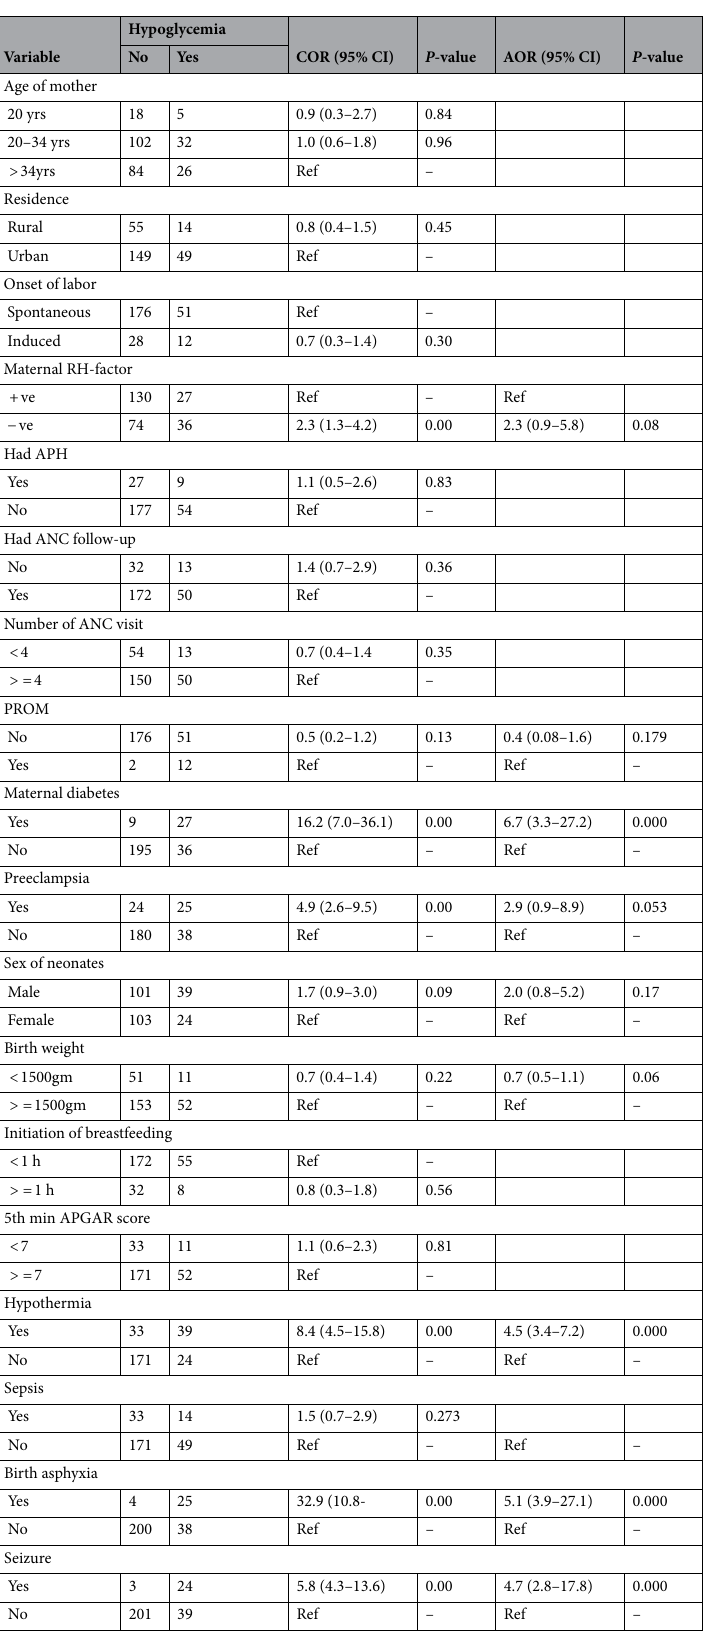
Table 2. Associated factors of hypoglycemia at Debre Tabor Comprehensive Specialized Hospital, Ethiopia, in 2021. APH, Antepartum Hemorrhage; ANC, Ante-natal care; APGAR, Appearance, Pulse, Grimace, Activity, and Respiration; DM, Diabetes mellitus; PROM, Premature rupture of membranes, RH,